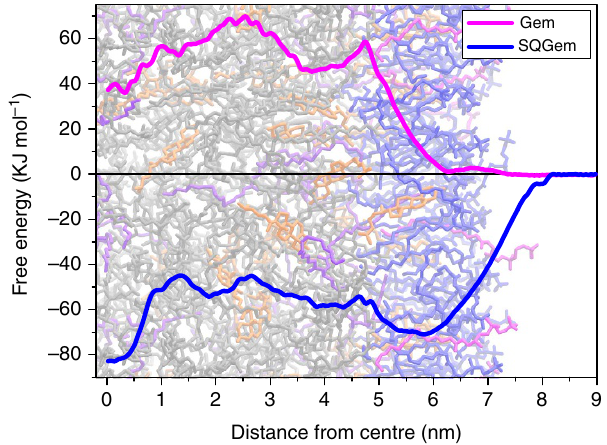
Figure 3 | Mean force potentials. Potentials of mean force of transferring individual Gem (magenta line) and SQGem (blue line) molecules from bulk water to the lipid core of model LDL particle. The plots are superimposed onto a snapshot of the equilibrated LDL system. 1-palmitoyl-2-oleoyl-sn- glycero-3-phosphocholine (POPC) lipids are shown in blue, 1-palmitoyl -2-hydroxy-sn-glycero-3-phosphocholine (lyso PC) in red, cholesterol in orange, cholesterol oleate in grey and glyceryl trioleate in violet.